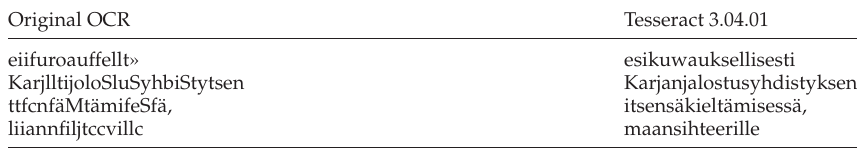
Table 4: Corrections of Levenshtein distance of